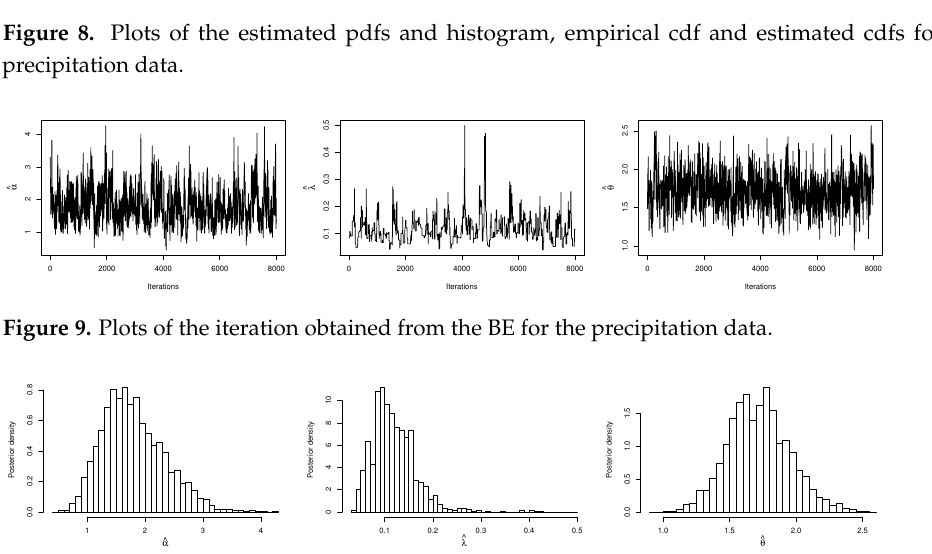
Figure 10. Plots of the posterior pdfs of each parameter from the BE for the precipitation